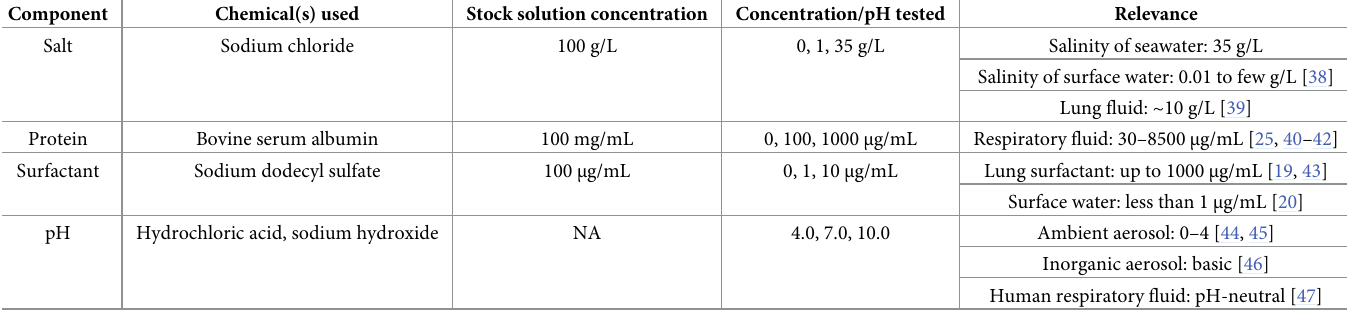
Table 1. Chemicals used to make solutions and their concentrations in virus